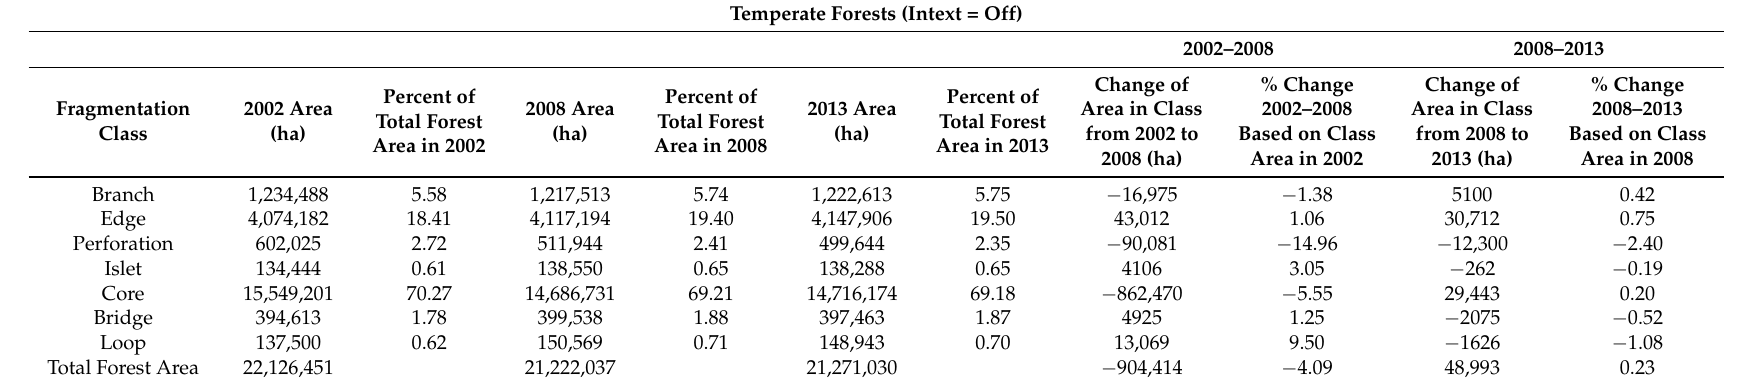
Table 3. Areas in each fragmentation class (intext = “Off”) for the temperate forests in 2002, 2008 and 2013. The differences in area in each fragmentation class and percent changes between dates are presented in the last columns on the right-hand